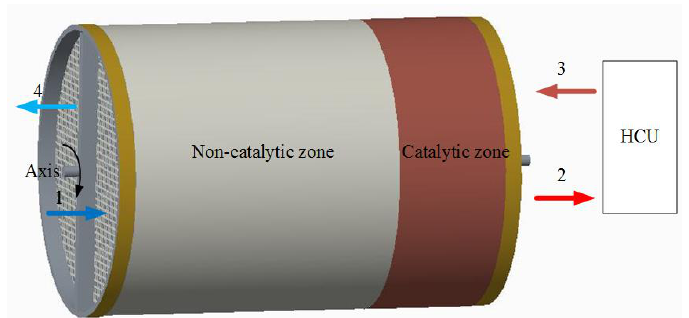
Figure 9. Schematic illustration of a rotary regenerator-type catalytic combustion reactor.